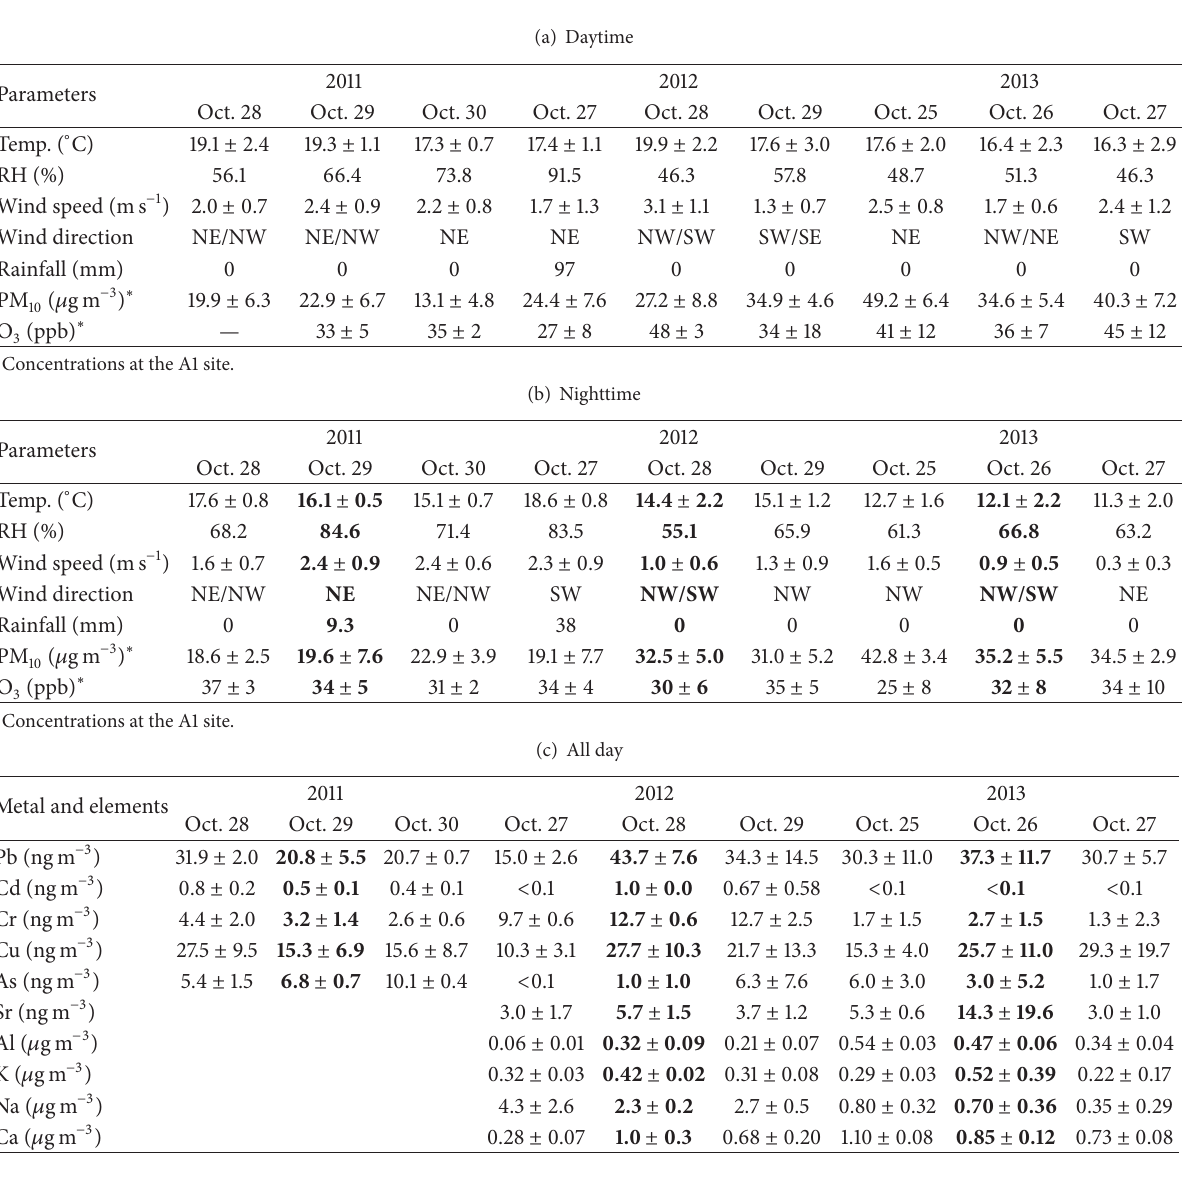
Table 1: Statistical summary (mean ± standard deviation) of meteorological parameters at two sites M1-M2 during the daytime (a) and